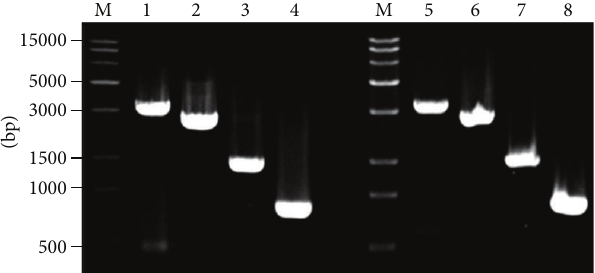
Figure 3: Cross-amplification PCR identification of recombinant Bacmid- Slp and Bacmid- Lsp-t. M represents the DNA molecular weight marker. Lanes 1–4 represent cross-amplification PCR products of the recombinant Bacmid- Slp with M13F and M13R, M13F and P1 󸀠 , M13R and P1, and P1 and P1 󸀠 as primers, respectively (see Section 2). Lanes 5–8 represent cross-amplification PCR products of the recombinant Bacmid- Lsp-t with M13F and M13R, M13F and P2 󸀠 , M13R with P2, and P2 and P2 󸀠 as primers, respectively.